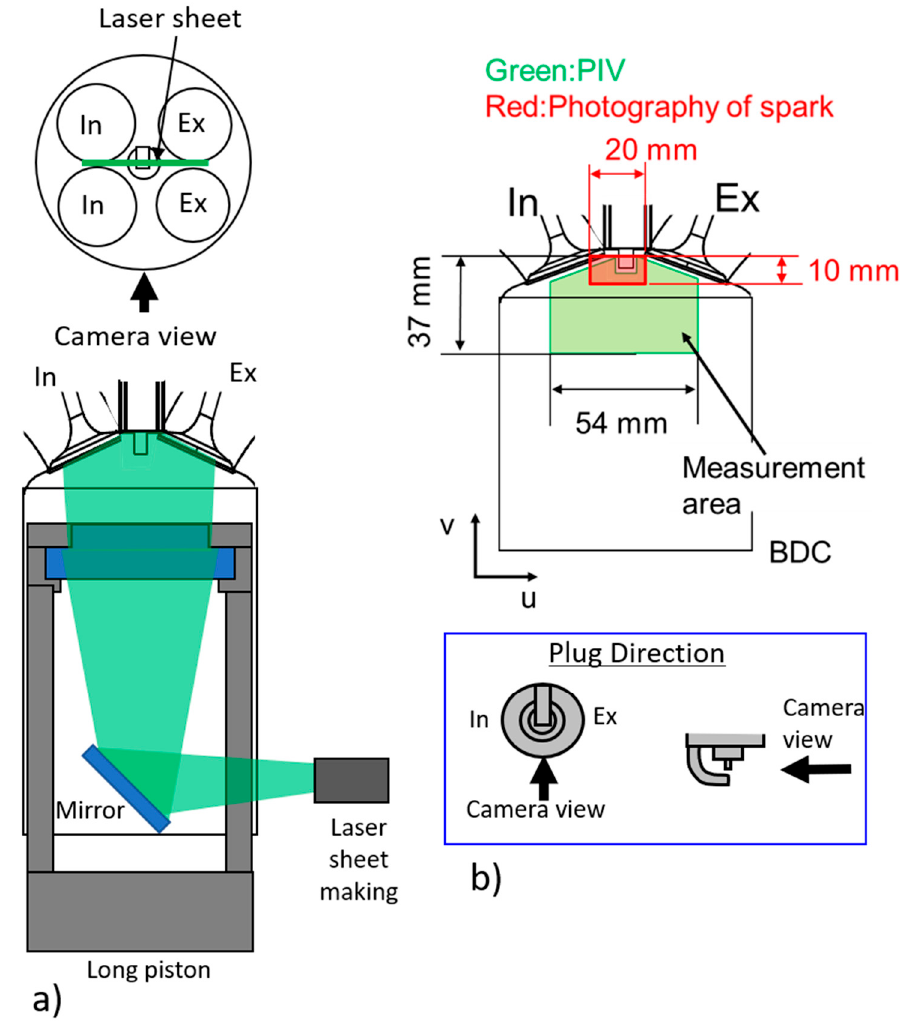
Figure 1. ( a ) Optical engine and PIV set up, ( b ) PIV measurement area, and position of the laser sheet with respect to the cylinder and plug direction with respect to the camera.